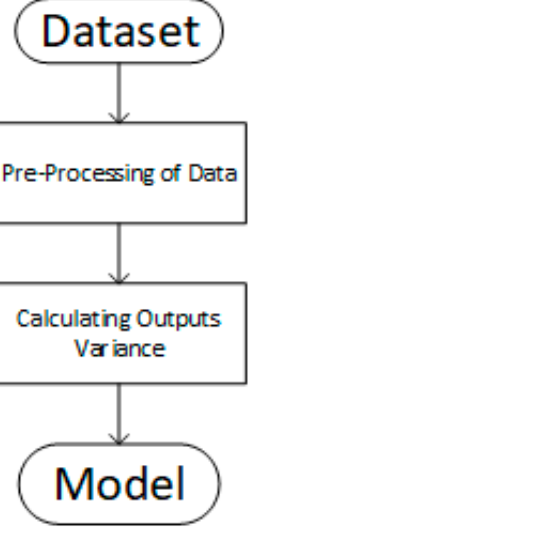
Figure 3. Flowchart of implemented algorithm.